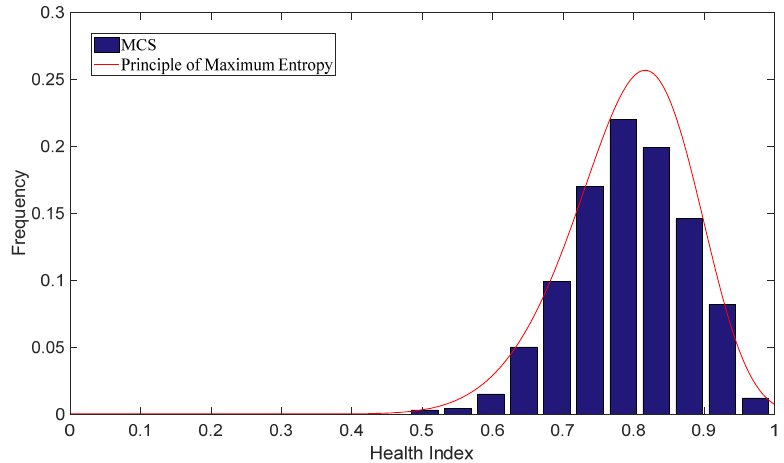
Figure 8. PDF of flight control system health index.